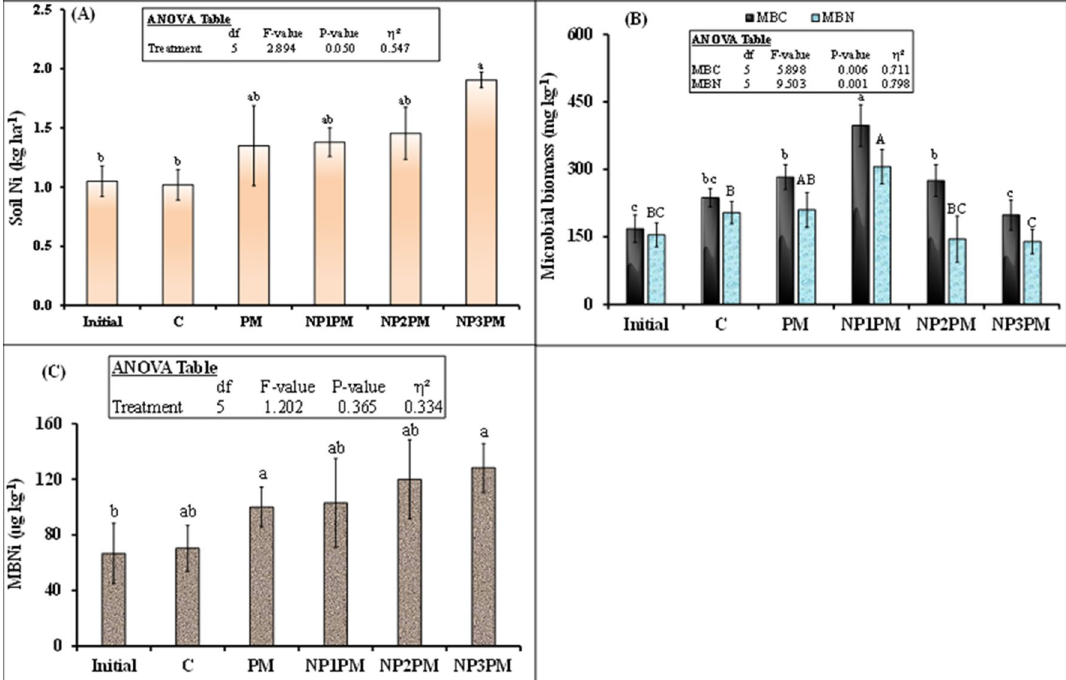
Figure 3. Mean (n = 3) ( A ) soil Ni content after 143 days of sowing ryegrass ( B ) microbial biomass carbon (MBC) and nitrogen (MBN) as well as ( C ) nickel (MBNi) at the start and end of experiment in the soil treated with poultry manure (PM) and three doses of nickel nanoparticles (NP). Treatments abbreviation can be found in the legend of Fig. 1. Error bars showed standard errors (± 1 SE) of the mean. Inset table indicates the analysis of variance (ANOVA). Multiple comparisons among treatments were analyzed by the Tukey-HSD